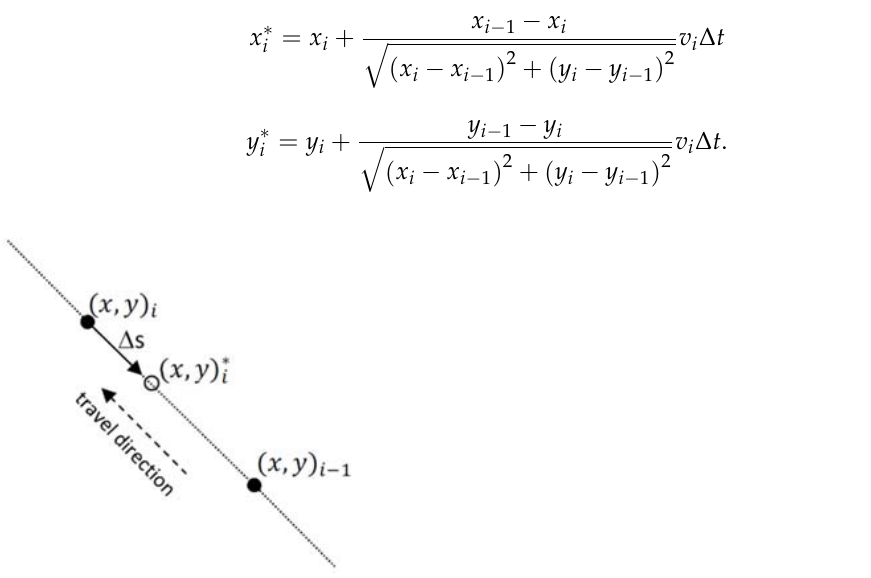
Figure 1. Schematic representation of the translation, Δ s , used to correct the spatial coordinates. The filled circles represent two consecutive original measurement locations, (cid:4666) 𝑥, 𝑦 (cid:4667) 𝑖−1 , and (cid:4666) 𝑥, 𝑦 (cid:4667) 𝑖 , while the empty circle represents the corrected location, (cid:4666) 𝑥, 𝑦 (cid:4667) 𝑖∗ , of the latter measurement.